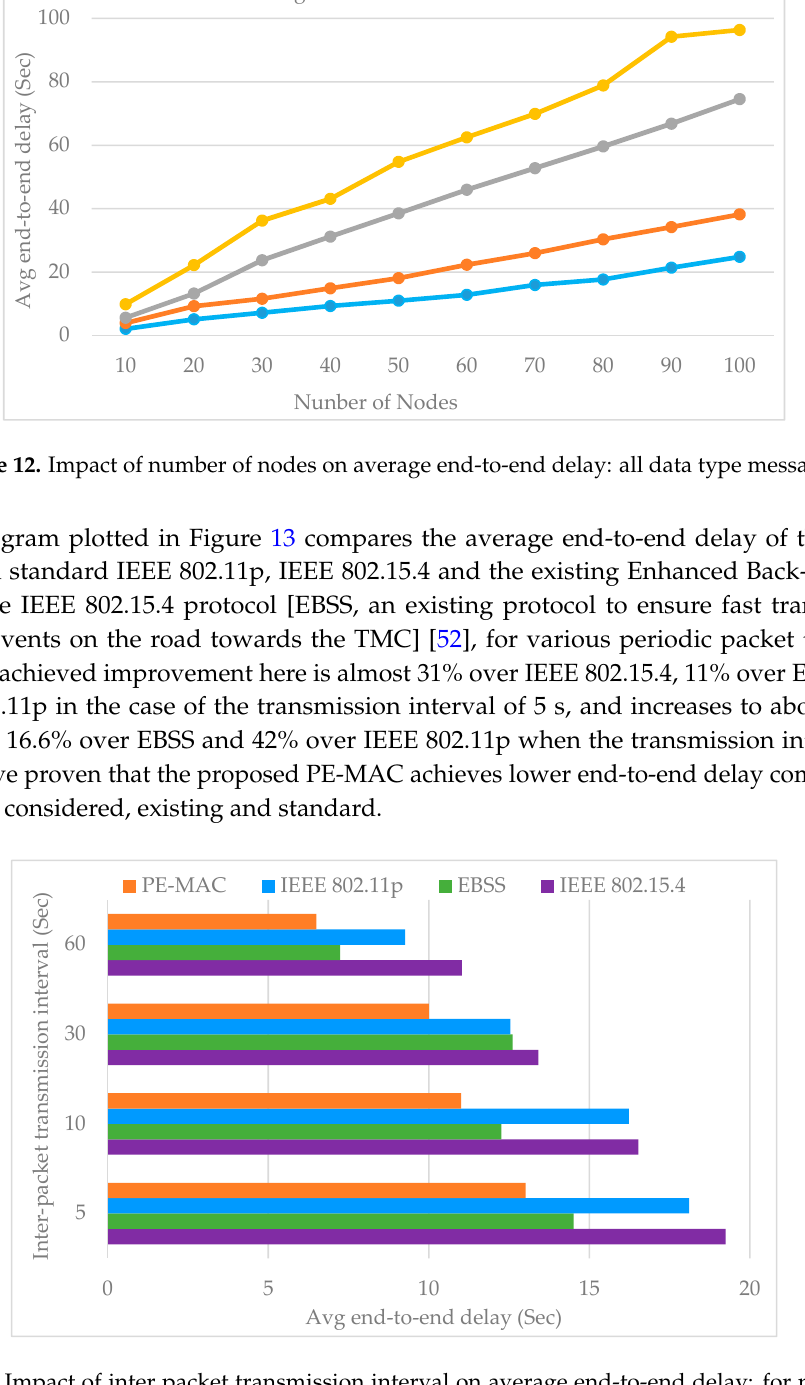
Figure 11. Impact of the number of nodes on throughput: proposed PE-MAC vs IEEE 802.11p.